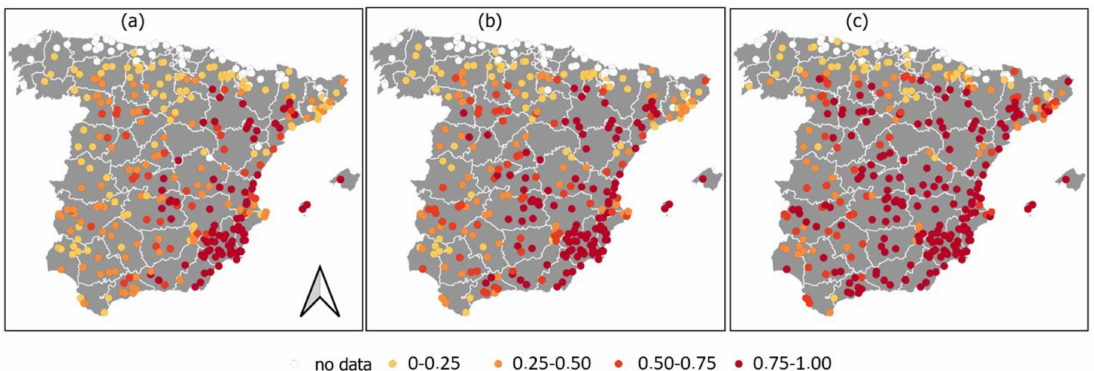
Figure 4. Average value of the dynamic stress indicator in Spain over the periods 2006–2040 ( a ); 2041–2070 ( b ); and 2071–2100 ( c ).